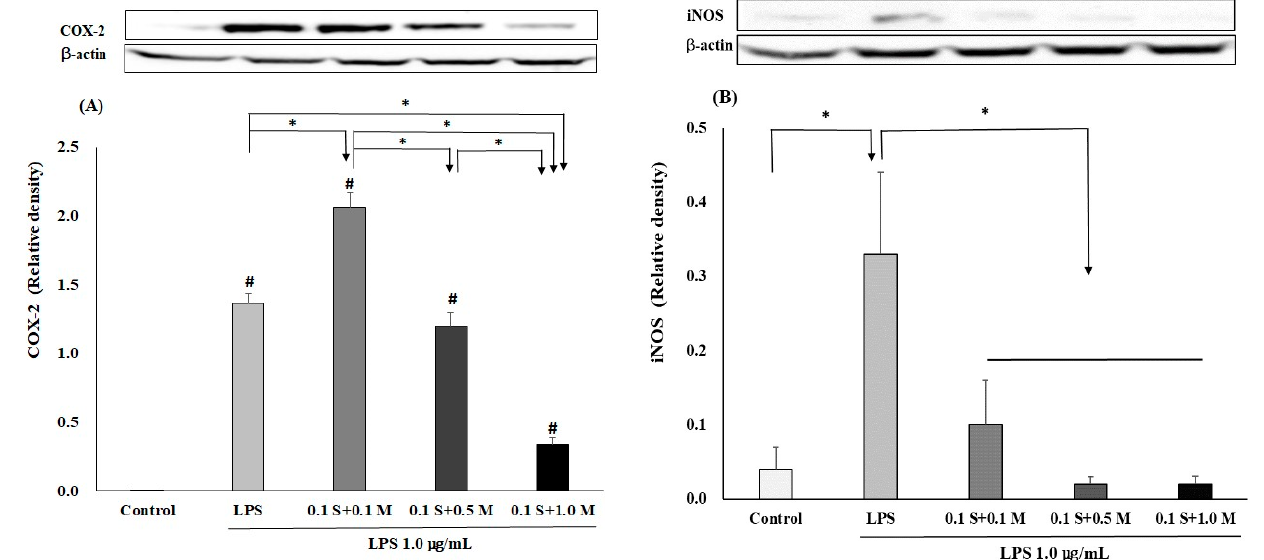
Figure 4. COX-2/iNOS expression based on the ratio of the sericin and MSM blends using Raw 264.7 macrophage. Cells were treated with 1.0 (0.1S + 0.1M), 5.0 (0.1S + 0.5M), and 10.0 (0.1S + 1.0M) mg/mL MSM at 1.0 mg/mL sericin, stimulated with 1 μ g/mL LPS. ( A ) COX-2 and ( B ) iNOS. Raw 264.7 lysates were Western blotted with an anti COX-2 or iNOS or β -actin antibody. All values are presented as the mean ± standard deviation (n = 3). # p < 0.05 vs. CON. * p < 0.05.